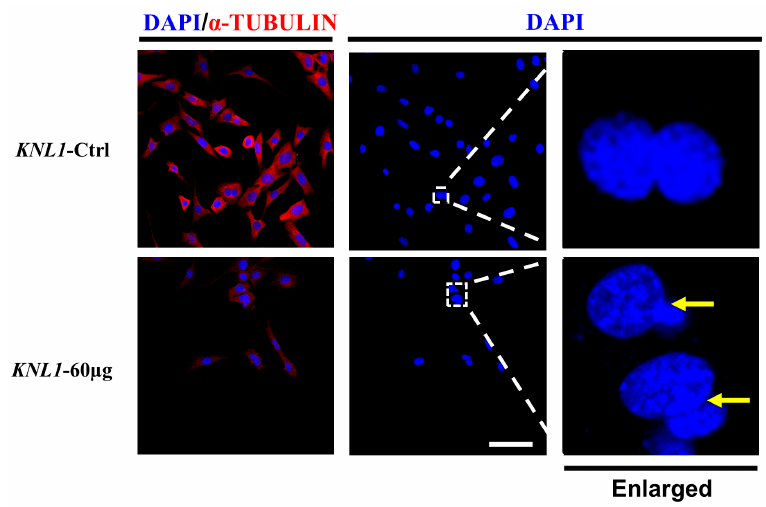
Figure 8. Effect of depletion of KNL1 on GC-2 cell separation. Fluorescent images of GC-2 cells interfered with by KNL1 siRNA. GC-2 cells were immunostained with anti- α -tubulin (red) and DAPI (blue). Merge was DAPI (blue) and anti- α -tubulin (red). The right represents the magnified portion of the white dashed box in the middle. The yellow arrow shows the cells that divide unequally. Bar = 50 µm.